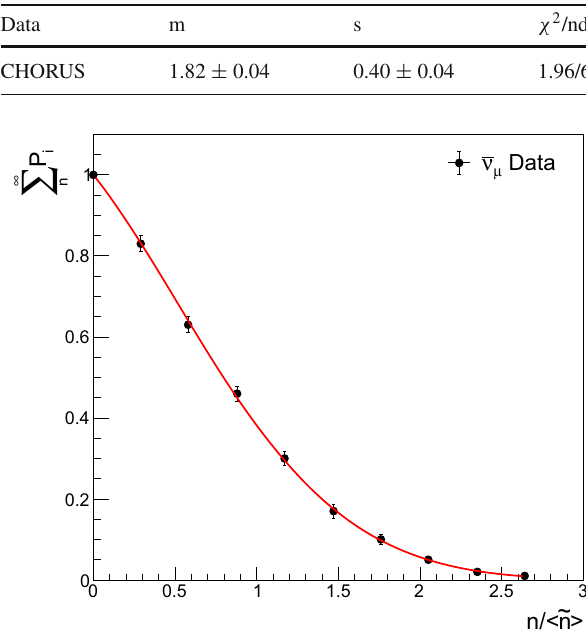
Fig. 3 The KNO-G scaling of ¯ ν μ data